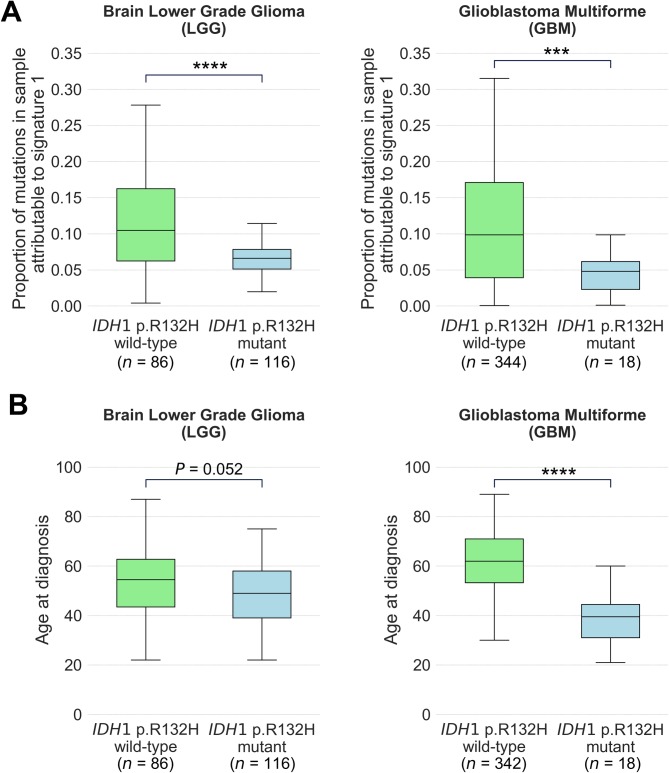
Associations of IDH1 p.R132H driver mutation with mutational signature 1 and with age at diagnosis of people with brain cancers.(A) Proportion of mutations attributable to signature 1 and (B) age at diagnosis of people with tumours that are wild-type and mutant for IDH1 p.R132H in brain lower grade glioma (LGG; left) and glioblastoma multiforme (GBM; right). Box plots show median and quartiles, with significance by two-sided Mann Whitney U-Test in (A) and unpaired t-test in (B). **** denotes P < 0.0001 and *** denotes P < 0.001.